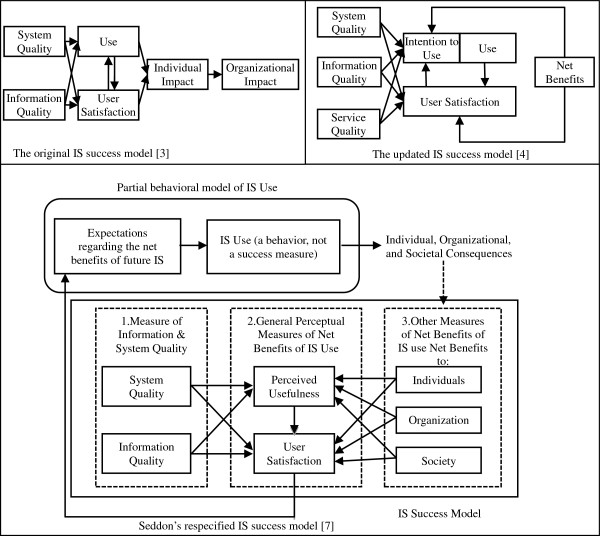
IS success models.